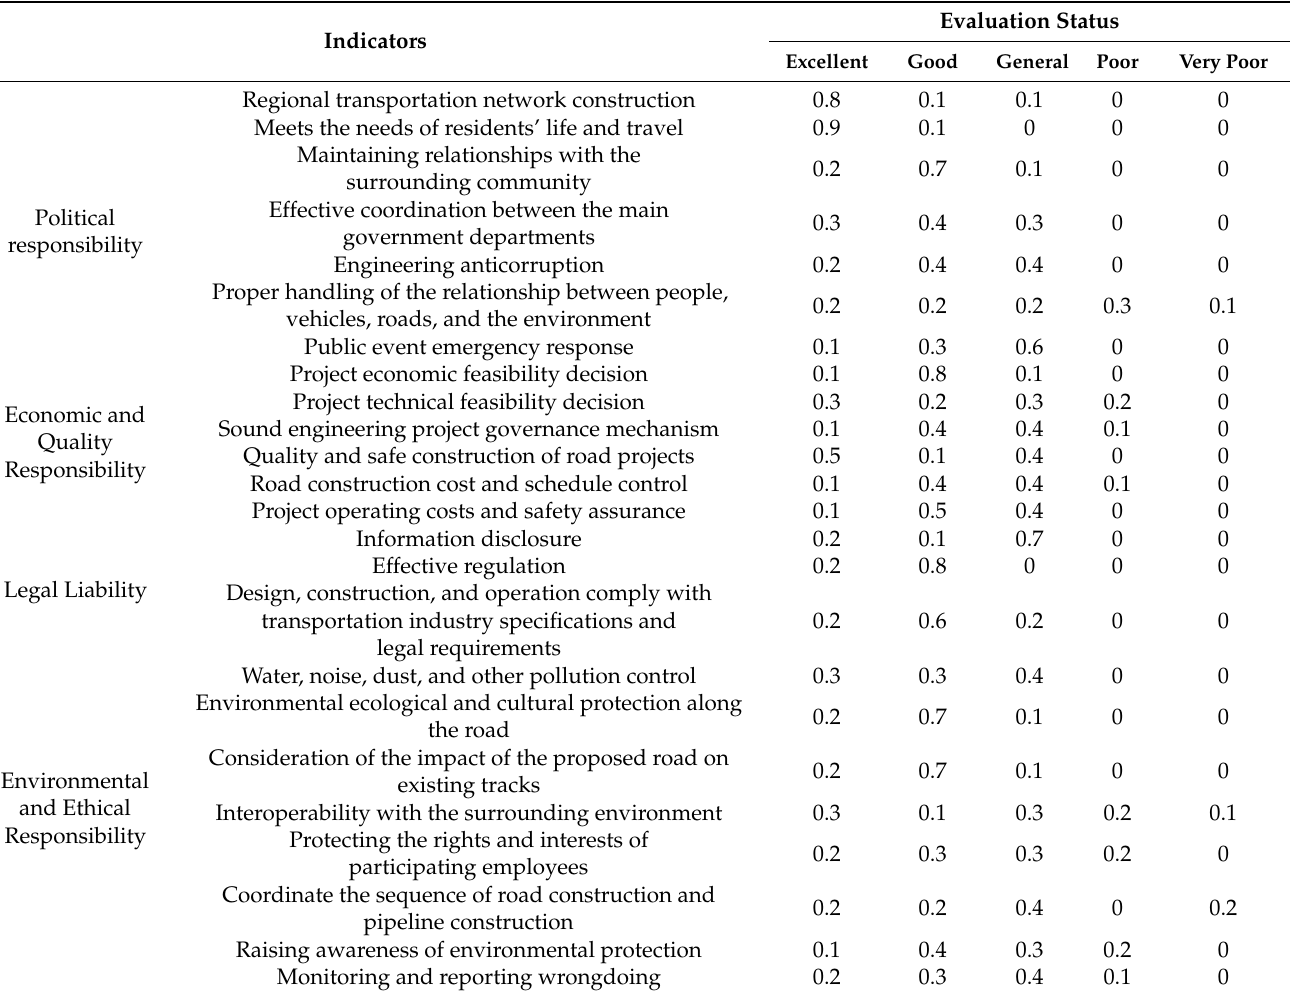
Table 4. MMRISR evaluation indicator survey